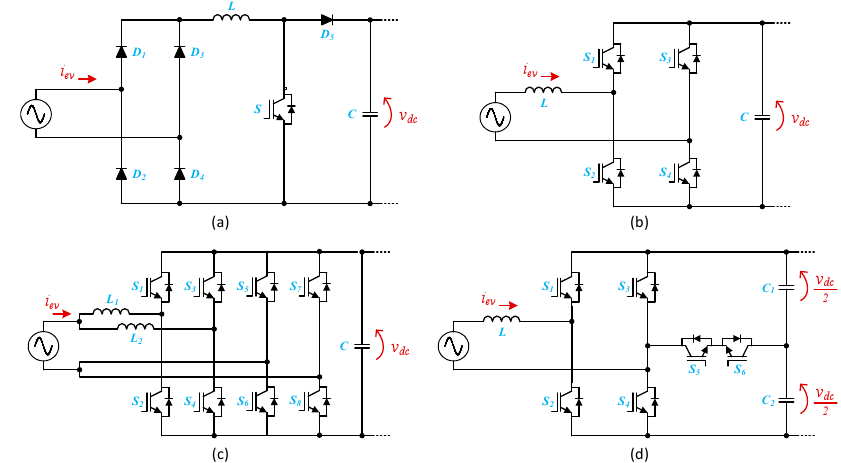
Figure 3. Main single-phase power electronics converters used as front-end power stage of on-board electric vehicle battery-charging system (EVBC): ( a ) unidirectional power factor correction; ( b ) bidirectional full-bridge; ( c ) bidirectional interleaved full-bridge; ( d ) bidirectional